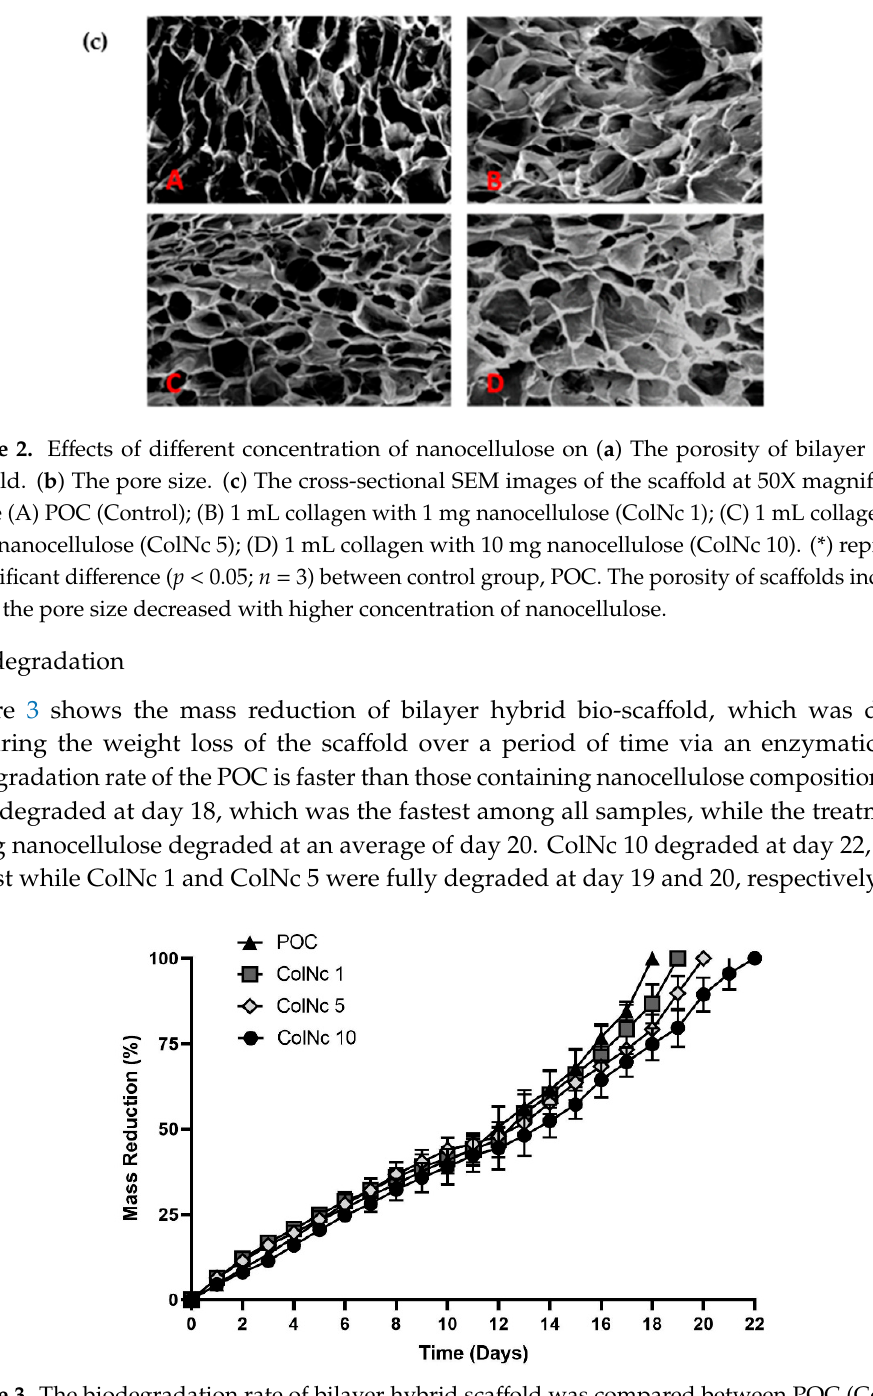
Figure 3. The biodegradation rate of bilayer hybrid scaffold was compared between POC (Control), 1 mL collagen with 1 mg nanocellulose (ColNc 1), 1 mL collagen with 5 mg nanocellulose (ColNc 5) and 1 mL collagen with 10 mg nanocellulose (ColNc 10). The average biodegradation rate for treated group was 20 days while POC was fully degraded at day 18.